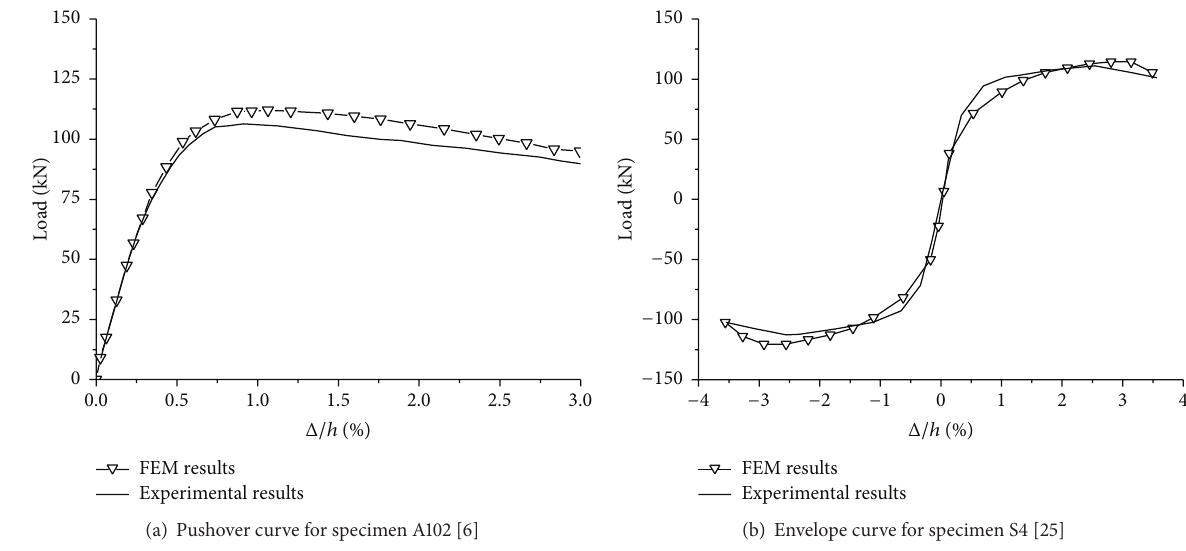
Figure 2: Verification of the finite element